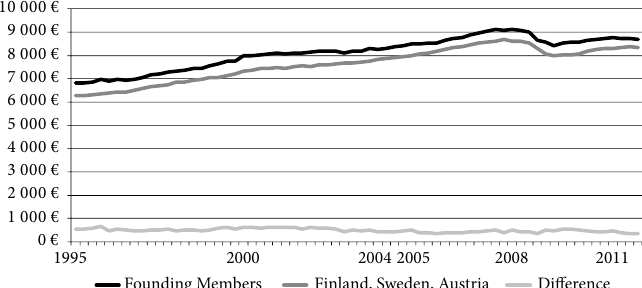
Fig. 3. Convergence in GDP per capita of EU founding members vs. Finland, Sweden and Austria Source : own